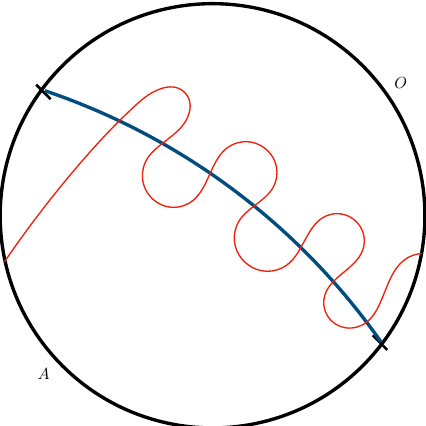
Figure 17 . Given a potential barrier it is always possible to construct a negative thread which crosses it an arbitrary number of times. Since the minimization program puts an upper bound on the barrier a negative thread can cross it is necessary to restrict the space of negative